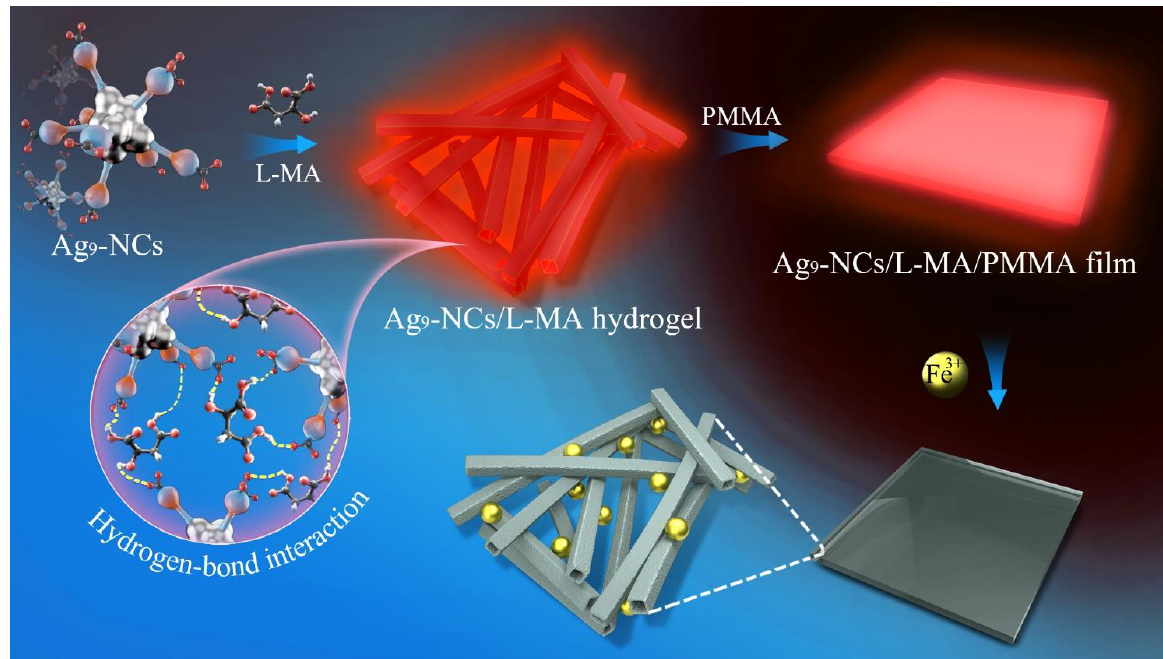
Scheme 1. Schematic illustration of the hollow-tube structure of Ag 9 -NCs/L–MA hydrogel and its composite film for highly sensitive detection of Fe 3+ .